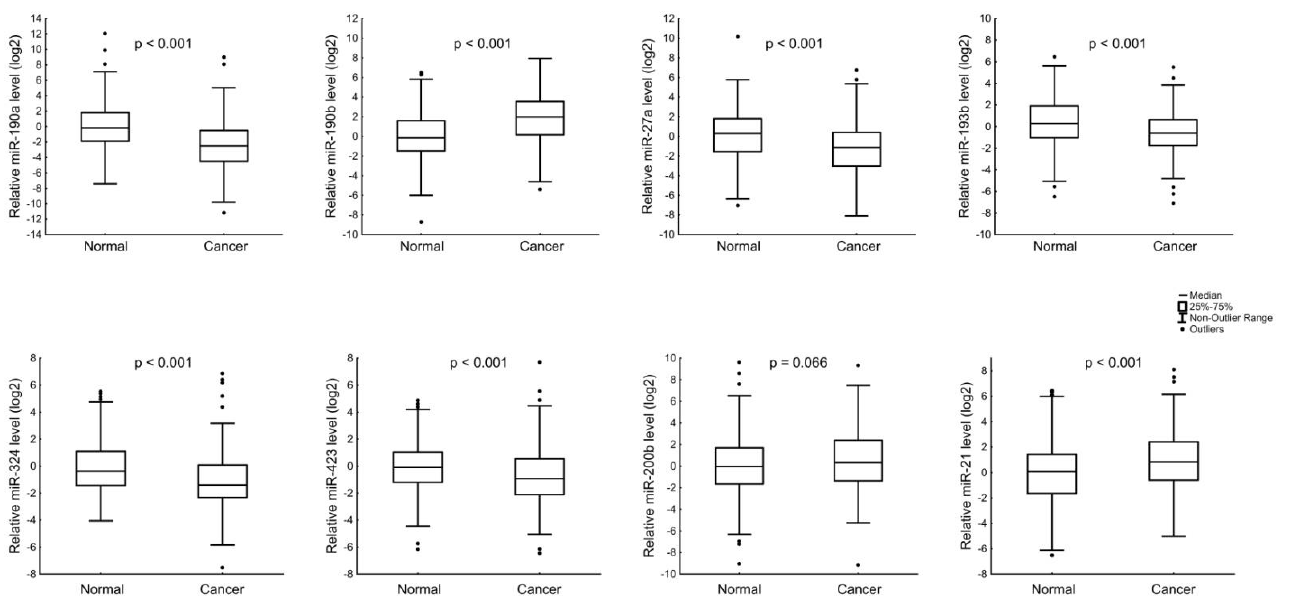
Figure 1. The comparison of miRNA expression between normal and cancerous tissue groups. The Y axis presents the expression level ( log 2 2 –ΔΔCt ).